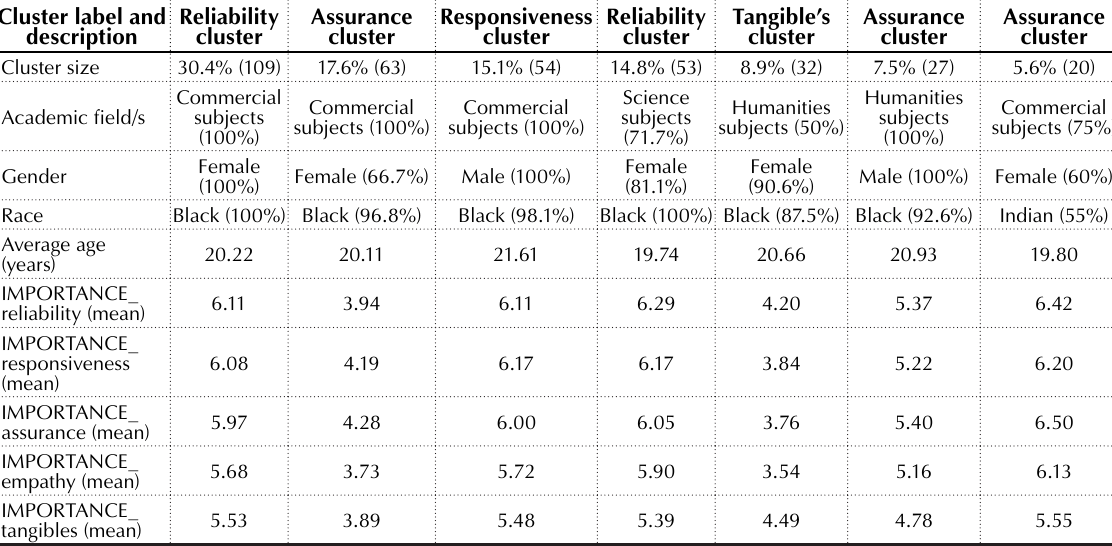
Table 10. Cluster analysis results Cluster label and